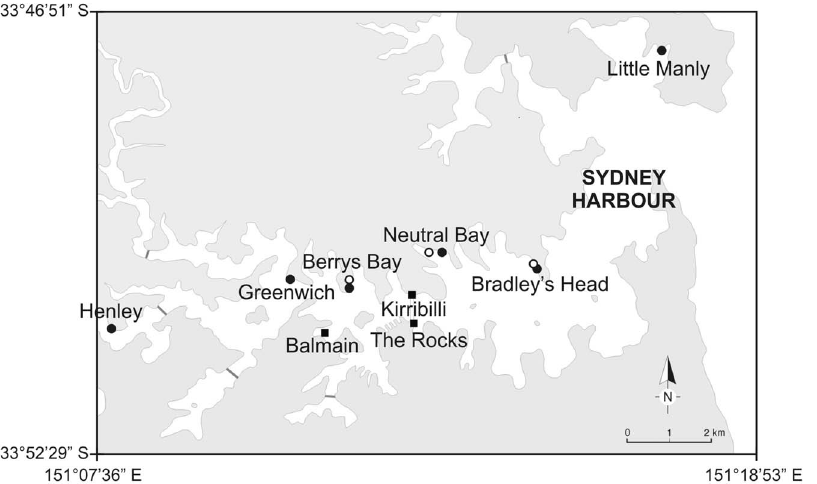
Figure 1. Locations sampled. Locations sampled in Sydney Harbour for oyster-beds (black circles), mussel-beds (squares) and coralline turfs (white circles).